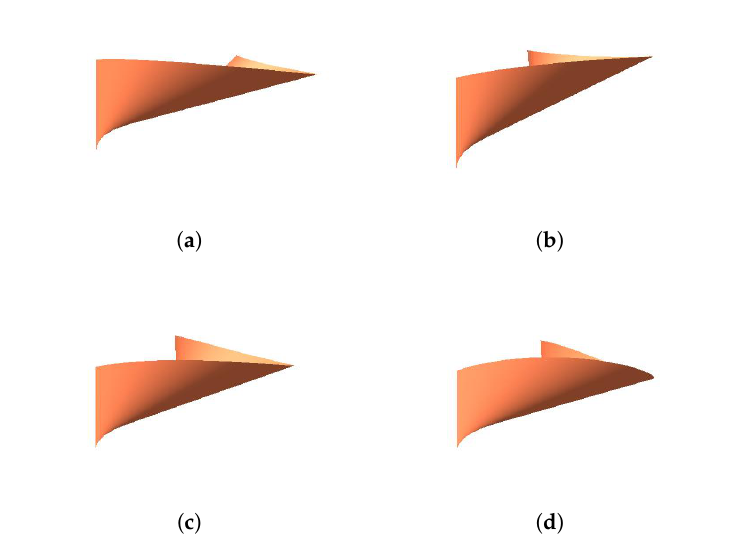
Figure 7. The effects of parameter α 1 on the tangent developable surface. ( a ) α 1 = π